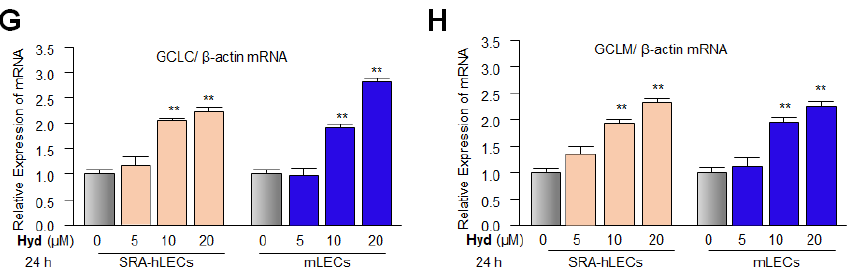
Figure 4. Hyd efficiently activated the Nrf2 antioxidant signaling pathway in LECs. ( A , B ) Hyd increased the cellular abundance of Nrf2 and Prdx6 protein in a dose-dependent fashion, as demon- strated by Western analysis of total cell lysate. Total cell lysate was isolated from SRA-hLECs ( A ) and mLECs ( B ) treated with different concentrations of Hyd for 24 h. Nrf2 and Prdx6 protein expression were analyzed using their corresponding specific antibodies; tubulin served as internal control. Nrf2 and Prdx6 protein band were scanned and quantified using a densitometry and were normalized with corresponding tubulin levels. Histograms represent the relative density values that were depicted on the right side of the protein band. The data represent the mean ± S.D. values of three independent experiments. Untreated vs. Hyd-treated LECs; ** p < 0.001. ( C – H ) Hyd significantly augmented levels of Nrf2 and its major target antioxidant genes examined, such as Prdx6, NQO1, HO1, GCLC, and GCLM. LECs were treated with different concentrations of Hyd for 24 h. Total RNA were isolated and processed for real-time PCR using specific primers. Data represent mean ± S.D. values of three independent experiments. Untreated vs. Hyd-treated LECs; * p < 0.05; ** p < 0.001.